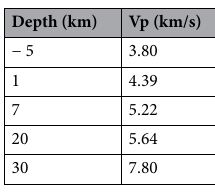
Table 1. The reference velocity model used for the inversion of experimental